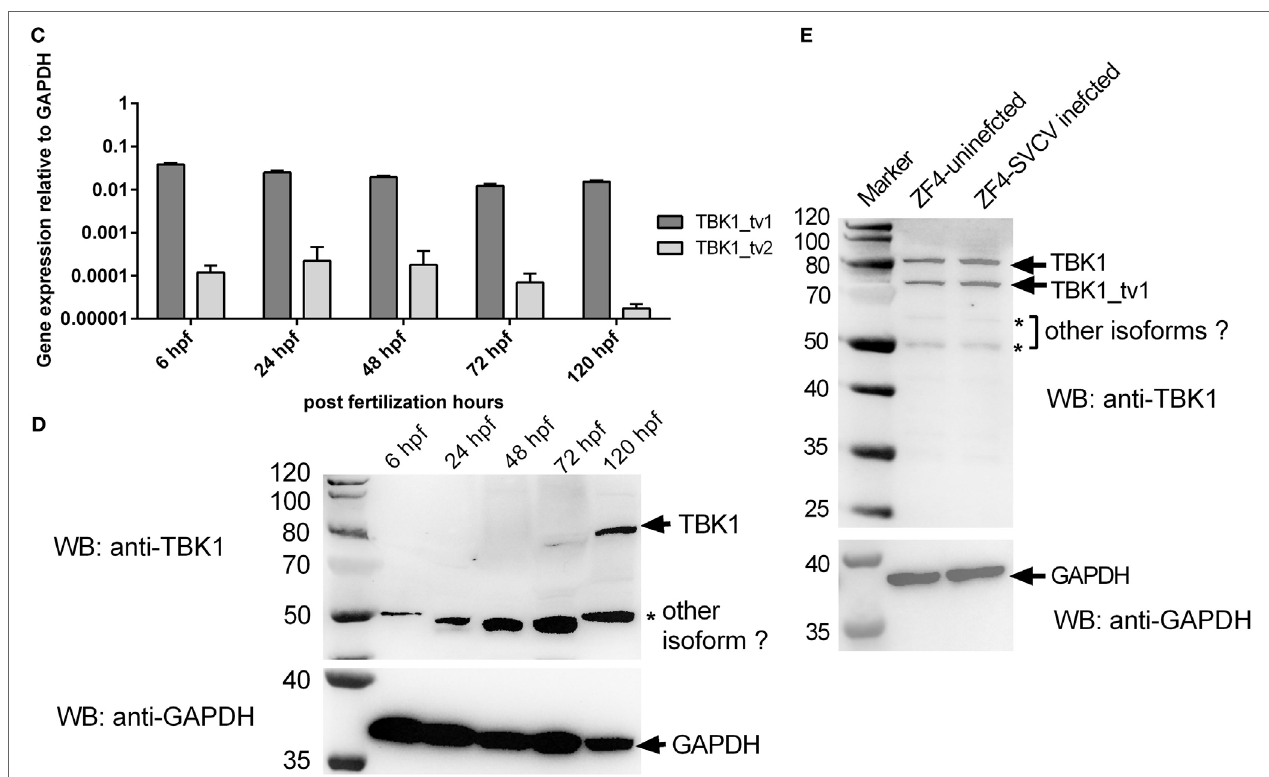
FigUre 1 | Identification of two spliced isoforms of zebrafish TANK-binding kinase 1 (TBK1). (a) Genomic and domain organizations of zebrafish TBK1 and its isoforms. Exons are square boxes; introns are straight lines. (B) Multiple alignments of amino acid sequences of zebrafish TBK1 and its isoforms. STKc_TBK1 and UBL_TBK1_like domains were indicated in two-way arrows. The amino acids which were used as immunogen against TBK1 polyclonal antibody are shown in red. (c) Expression of zebrafish TBK1_tv1 and TBK1_tv2 isoforms during development. Total RNA was extracted from development samples including 6, 24, 48, 72, and 120 h postfertilization. Data represent mean ± SEM ( n = 3). (D) Expression of zebrafish TBK1 protein during development. Total protein was extracted from development samples including 6, 24, 48, 72, and 120 h postfertilization. Each Western blot is representative of two independent experiments. (e) Protein expression of zebrafish TBK1 and its isoforms in ZF4 cells with/without spring viremia of carp virus (SVCV) infection. ZF4 cells were passaged in six-well plates at 1 × 10 6 cells per well. Then the cells were infected with SVCV at a multiplicity of infection of 1. The cells were collected at 36 h post infection and used for protein extraction. Cell lysates were immunoblotted using anti-TBK1 antibody (1:5,000, upper panels) and anti-GAPDH antibody (1:2,000, lower panels). Each Western blot is representative of at least two independent